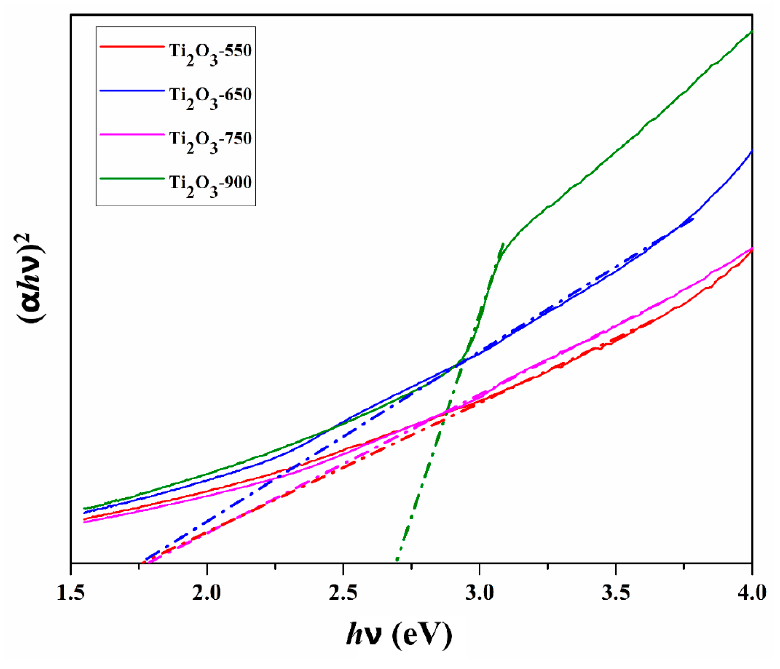
Figure 12. Tauc plot of treated Ti 2 O 3 catalysts.